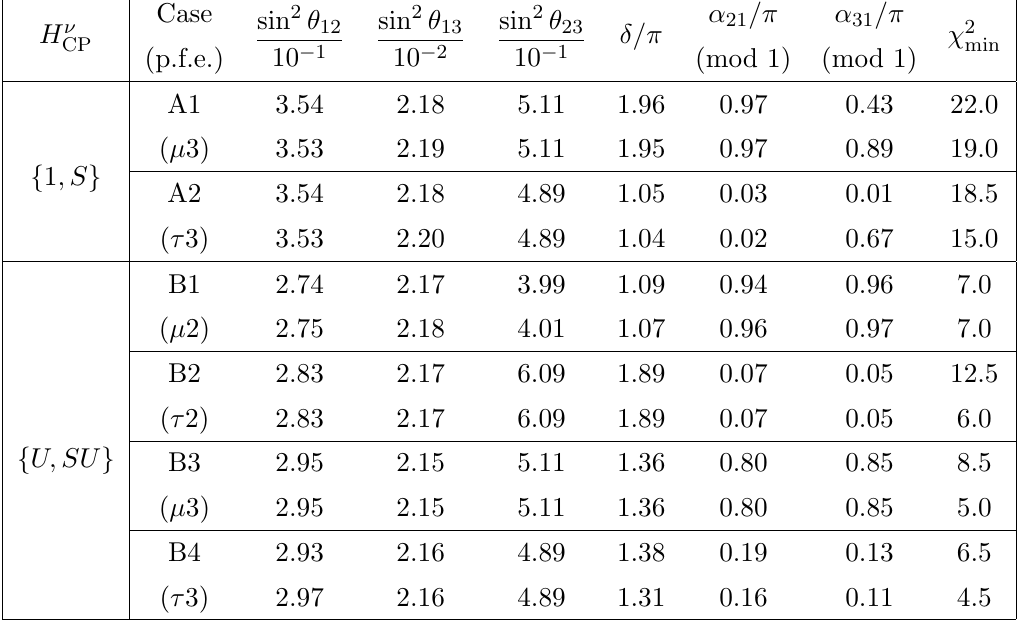
Table 5 . Best (cid:12)t values of the mixing parameters and the corresponding value of the (cid:31) 2 function, (cid:31) 2 , for the viable cases, i.e., those cases for which the predicted values of all the three mixing min angles lie inside their respective 3 (cid:27) allowed ranges. The cases presented here correspond to G e = Z g e and G (cid:23) = Z g (cid:23) (cid:2) H (cid:23) with f g e ; g (cid:23) g = f TU; S g , for which the magnitude of the (cid:12)xed element is p 2 CP 1 = 2 (p.f.e. denotes its position in U PMNS ). For each case, the upper and lower rows refer to NO and IO,